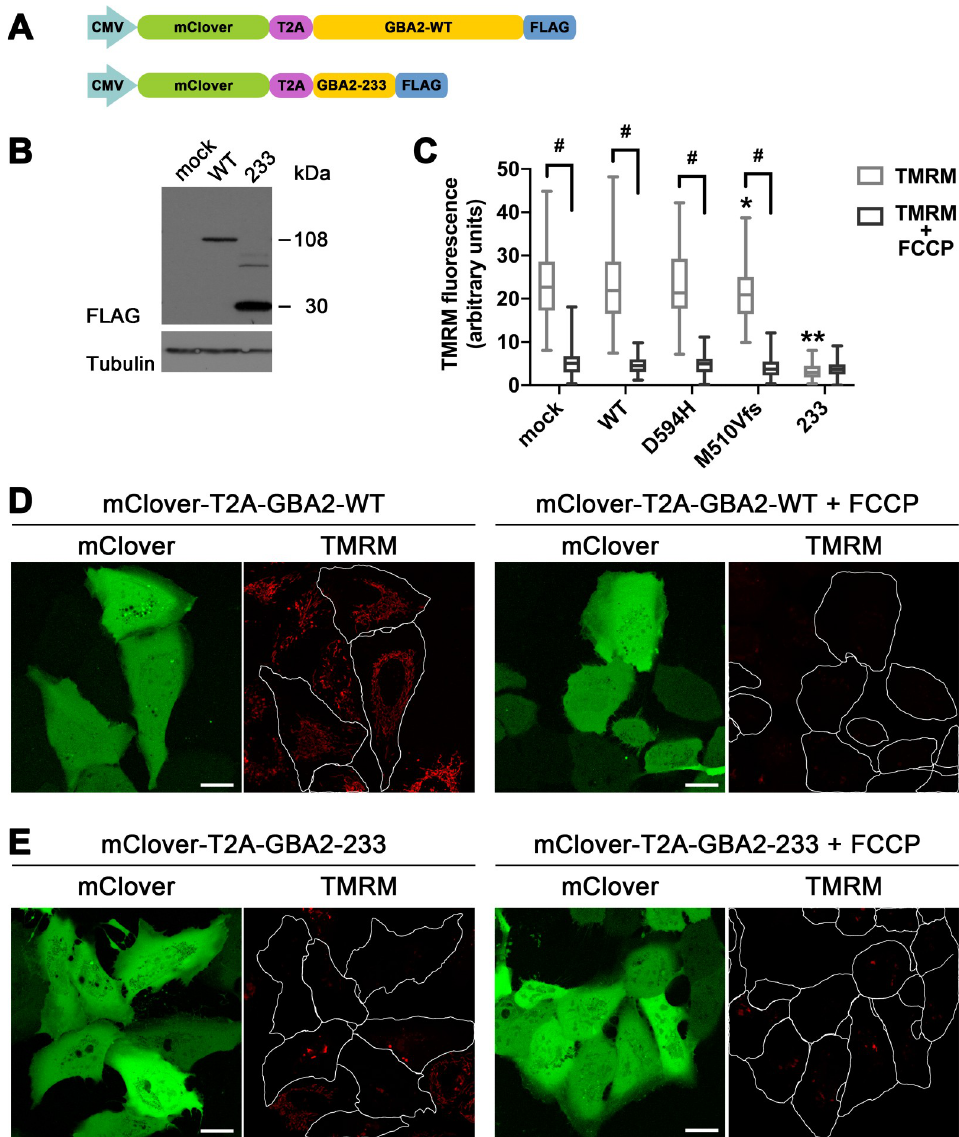
Fig 6. GBA2-233 depletes the mitochondrial transmembrane potential. (A) Schematics of cDNA constructs allowing the co-expression of mClover and WT or GBA2-233. Similar constructs were used for the co-expression of mClover and GBA2-D594, GBA2-M510Vfs � 17. (B) Western blot prepared with lysates from U2OS cells transfected with the constructs depicted in [A] probed with an anti-FLAG antibody; apparent molecular weights are indicated. (C) Quantification of transmembrane potential in non-transfected cells and in cells expressing GBA2-WT, GBA2-D594, GBA2-M510Vfs � 17, and GBA2-233 (30 cells were analyzed for each of three independent experiments; whiskers, 1–99 percentile). Fluorescence intensity was quantified after exposure of cells to TMRM. Statistical comparisons for the impact of FCCP, using one-way nested ANOVA: #, P < 0.0001. Statistical comparisons with GBA2-WT: � , P = 0.0488; �� , P < 0.0001. (D) Non-transfected cells and cells co-expressing mClover (green) and GBA2-WT were imaged live by confocal microscopy after exposure to TMRM (red) (left two panels) or TMRM and FCCP (right two panels). (E) Non- transfected cells and cells co-expressing mClover (green) and GBA2-233 were imaged live by confocal microscopy after exposure to TMRM (red) (left two panels) or TMRM and FCCP (right two panels). Scale bar, 20 μ m. observed GFP-GBA2 and GBA2-GFP at the plasma membrane of COS-7 cells. Also, many of the fluorescence microscopy images of Ko¨rschen et al . [41] show a wide distribution of differ- ently-tagged forms of murine Gba2 throughout transfected HEK293 cells (eGFP-Gba2,